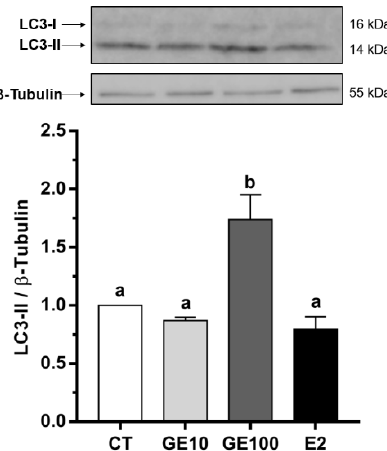
Figure 2. In vitro effects on pre-confluent rainbow trout preadipocytes incubated at day 5 of culture for 24 h with GE at different concentrations (10 and 100 μM), E2 (1 μM), or vehicle (0.1% DMSO) as CT. Representative Western blots and quantification of LC3-II protein levels normalized to β-tubulin. Data are shown as mean + SEM ( n = 4–6). Significant differences among treatments were determined by one-way ANOVA and are indicated by different letters ( p < 0.05). CT: Control; GE: Genistein; E2: 17β-estradiol.